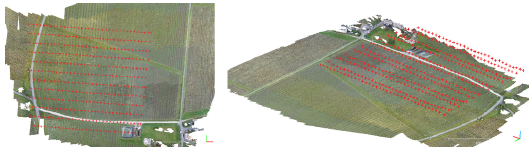
Figure 14. FORMap success to calibrate all images in the Oblique dataset despite of non post processed GNSS